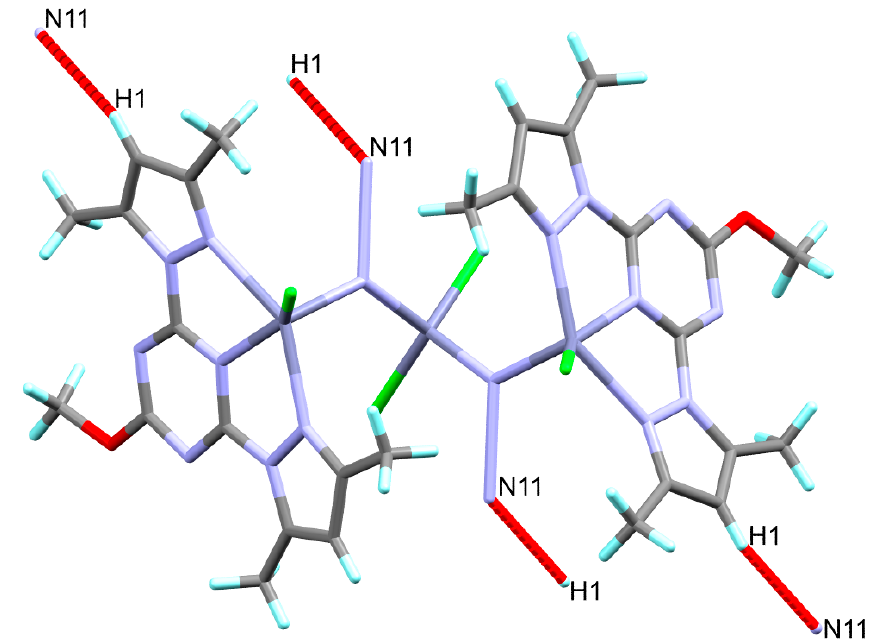
Figure 3. The hydrogen bond contacts in the [Zn 3 (PMT) 2 (Cl 4 )(N 3 ) 2 ] complex.